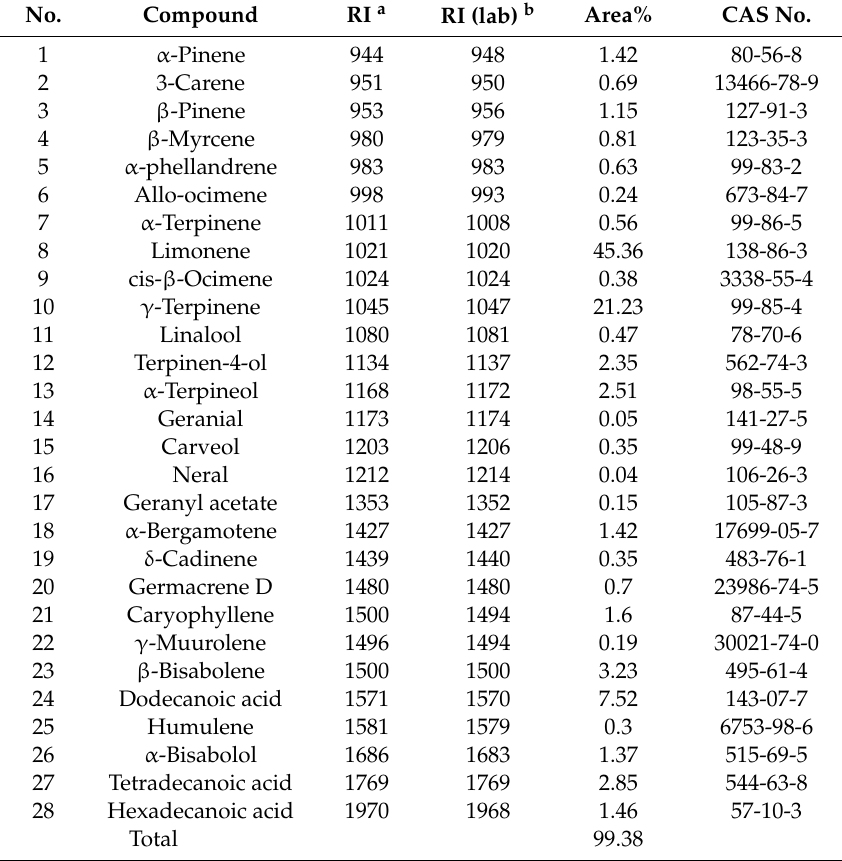
Table 1. Components of the essential oil from finger